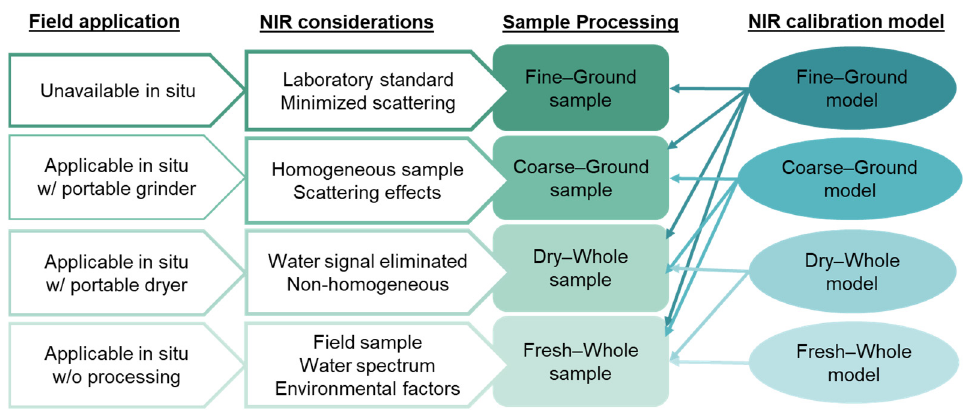
Figure 2. Flow chart of the sample processing for NIR data collection from field samples to the most processed for obtaining the best NIR spectra. The sample processing steps eliminate complicating factors in the NIR spectrum, such as overlapping water signals, mixture inhomogeneity, and scattering from variable particle size and shape.